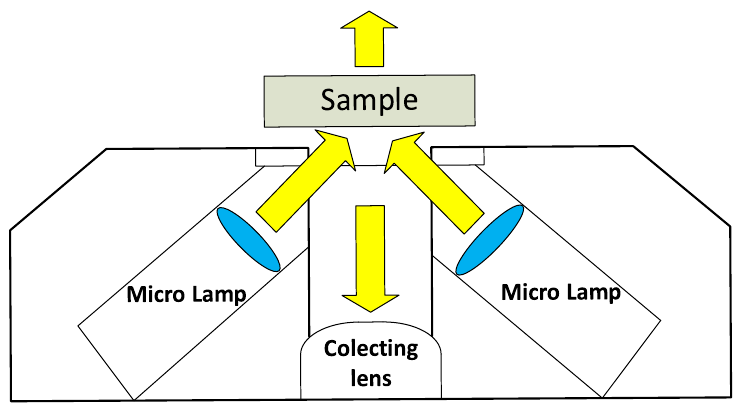
Figure 1. Method of performing measurements in reflectance mode.